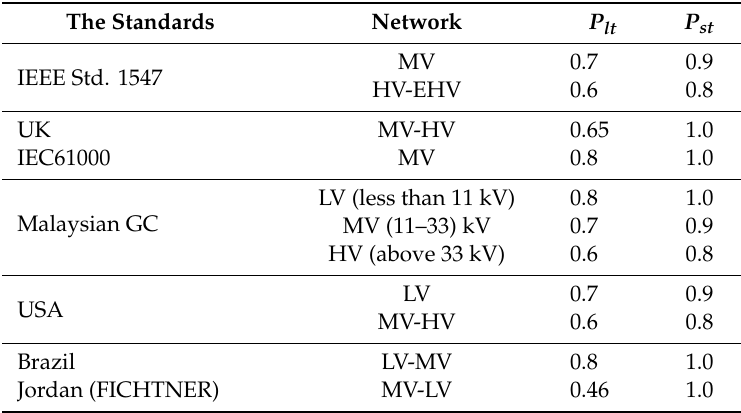
Table 1. Voltage flicker limits at di ff erent voltage levels.